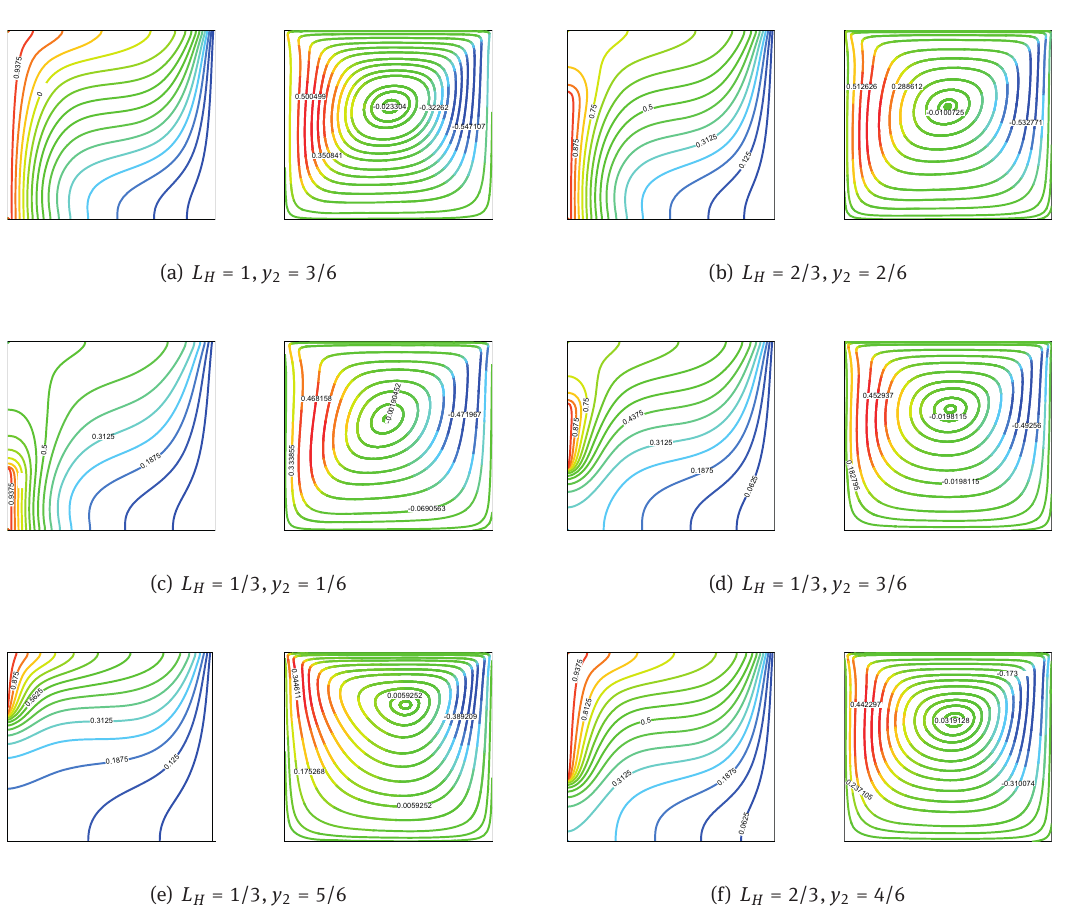
Fig. 4: Isotherms (left) and Streamlines (right) for different size and locations of the heat sourec with Ri = 100 , Da = 10 −2 , ϵ = 0.4 , and χ = 0.06